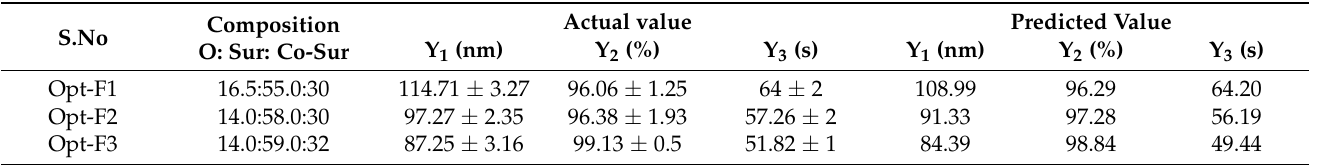
Table 4. Point prediction optimized composition CEP-SNEDDS.